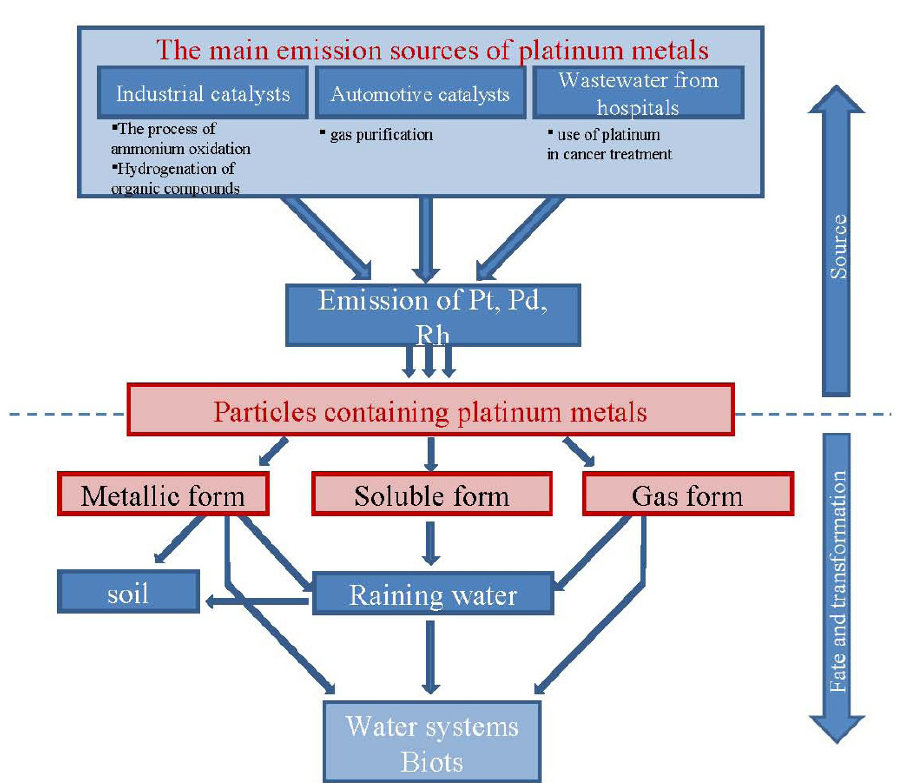
Figure 2. The main sources of emissions of platinum metals are primarily industrial and automotive catalysts as well as wastewater from healthcare, where they are used for platinum anticancer therapy. Industrial catalysts are used for various oxidation processes and organic compounds hydrogenation, while automotive catalysts are used to clean exhaust gases. Platinum metals particles enter into the environment. The nature of the particles determines the next cycle. Metal form usually goes directly into the soil, but can be dissolved in small concentrations of acid rain. Soluble form is getting into the water cycle and can be retained in the soil. Similarly, it is in gaseous form. Therefore, all the particles get to the water systems and biota.